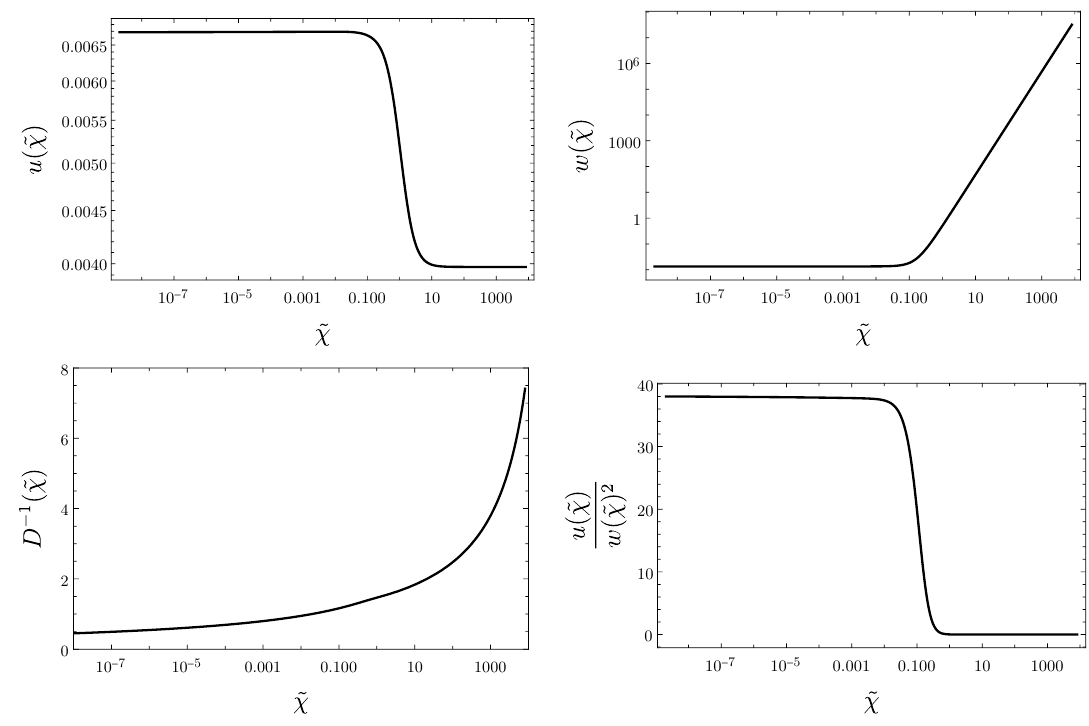
Figure 10 . Critical trajectory of u (˜ χ ) (top-left), w (˜ χ ) (top-right), D − 1 (˜ χ ) (bottom-left) and u (˜ χ ) /w (˜ χ ) 2 (bottom-right) as functions of ˜ χ in the U + R + C 2 truncation, for N S = N V = N F = 0